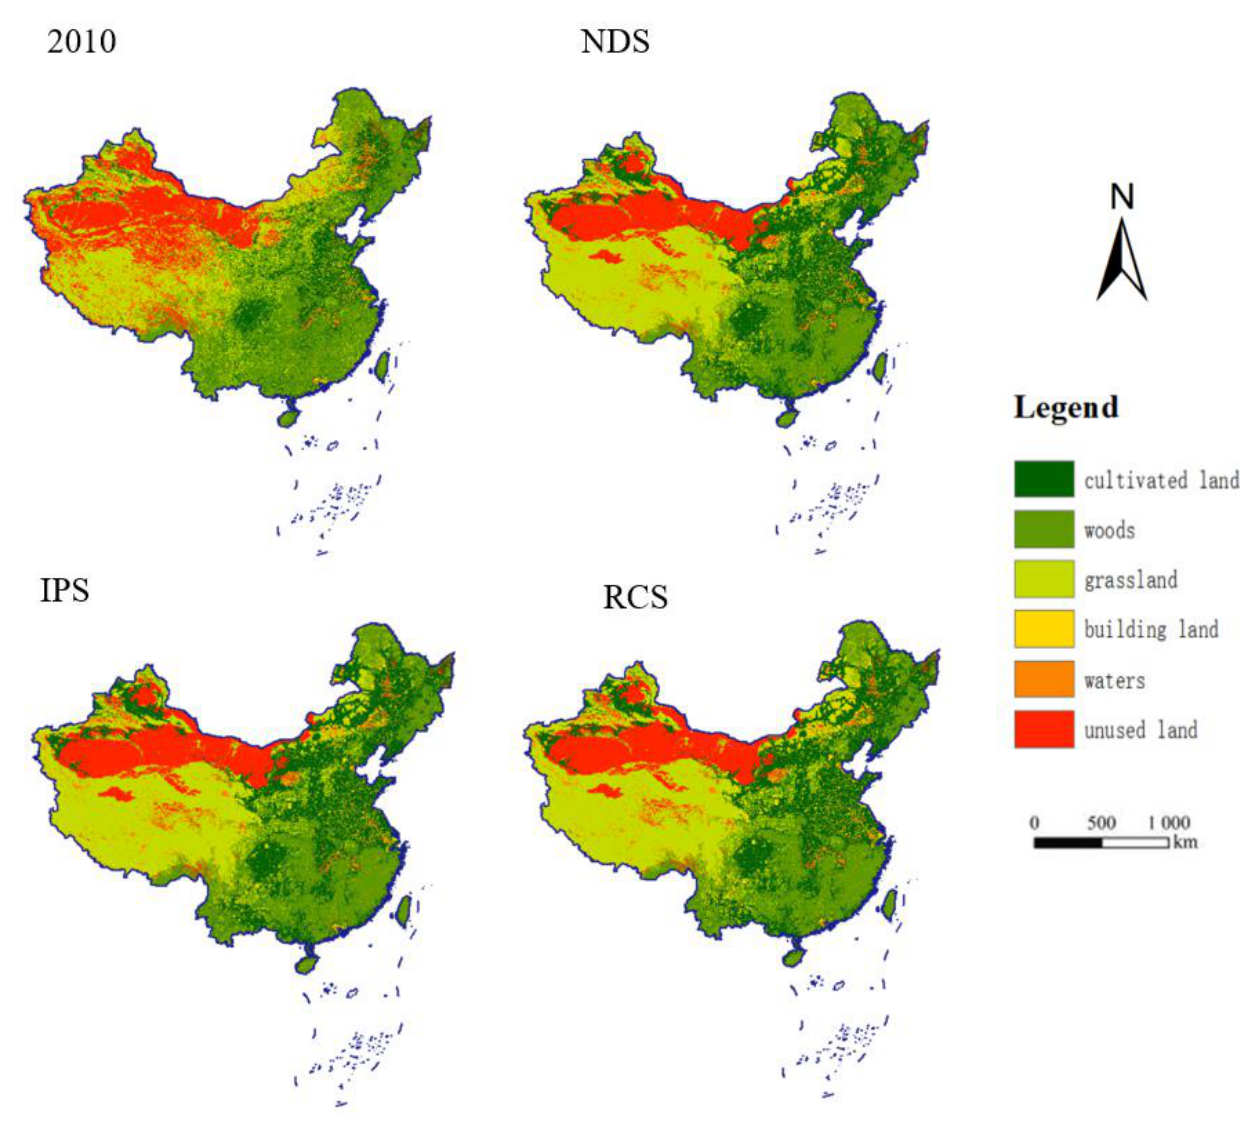
Figure 2. CLUMondo simulation of land use